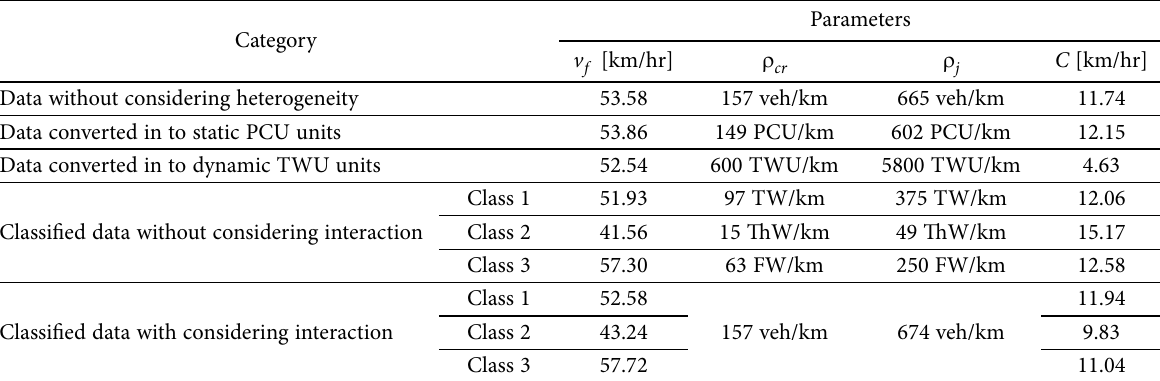
Table 1. Parameters of the derived steady-state speed-density